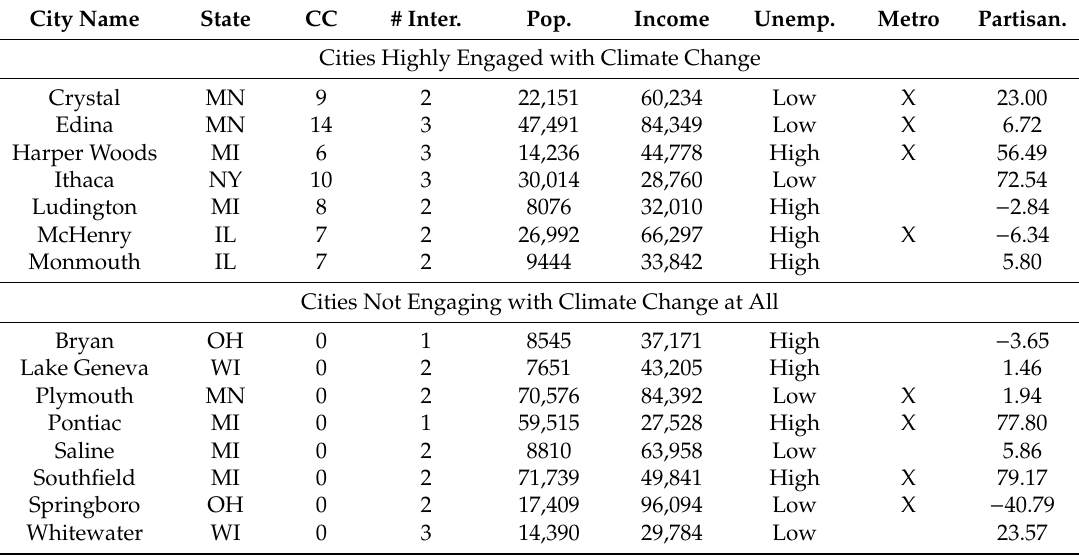
Table 1. Summary of cities